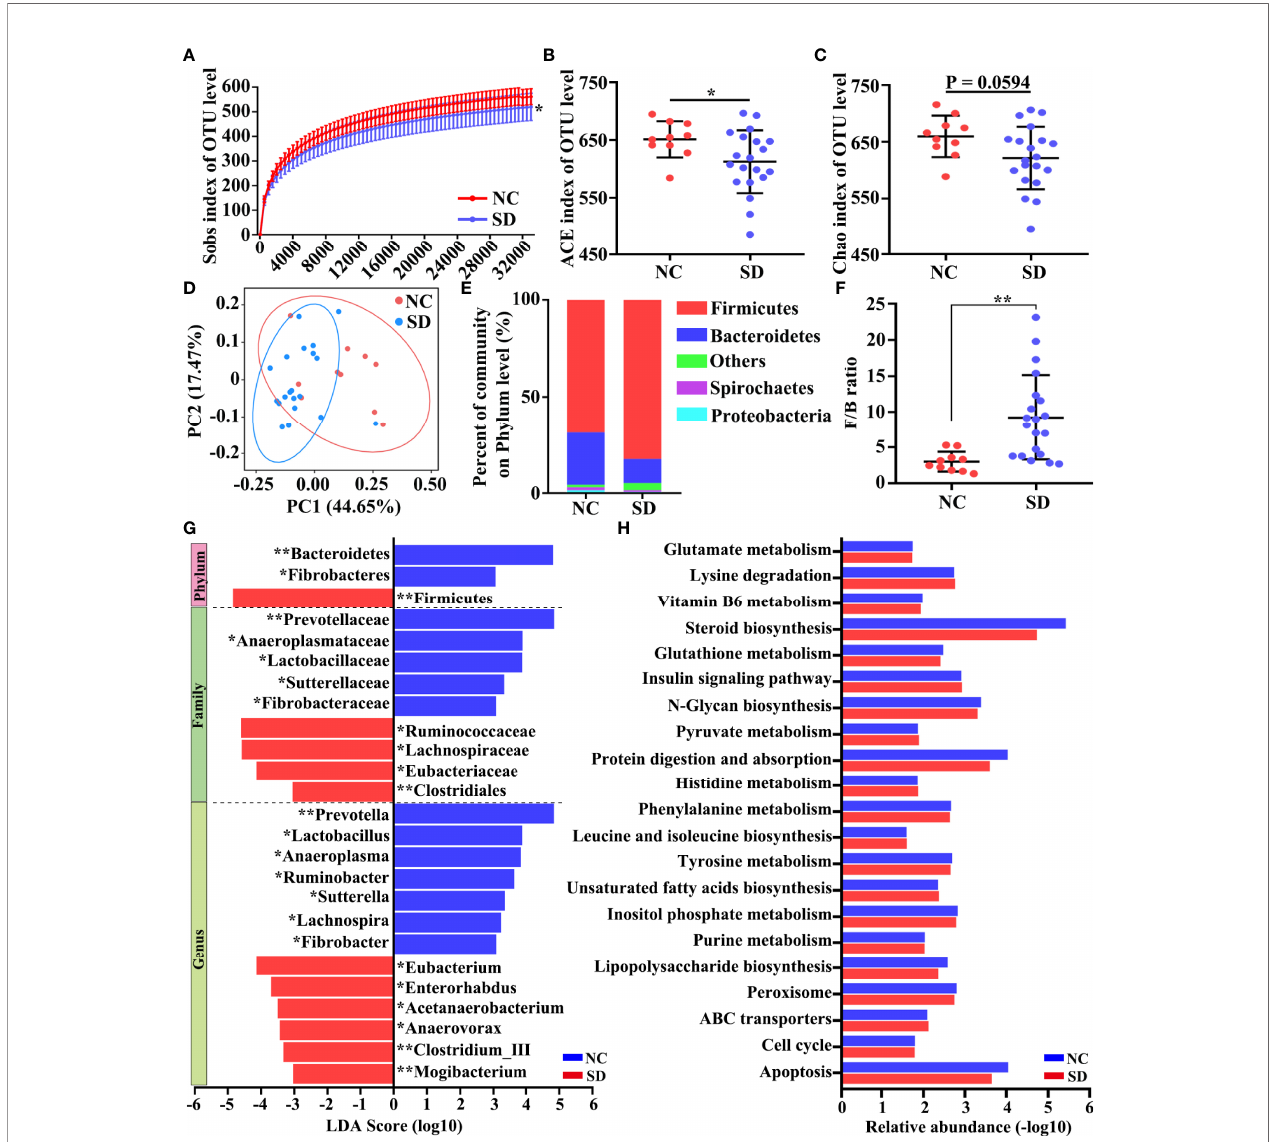
FIGURE 2 | Effects of sleep deprivation (SD) on intestinal microbial community structure in rhesus monkeys (RMs). (A) Rarefaction curves for the gene number in the control ( n = 10) and SD ( n = 20) groups. The curve in each group is nearly smooth with a suf fi cient amount of sequencing data and a few new undetected genes. (B, C) ACE and Chao indices were used to estimate the a -diversity of the gut microbiota community. (D) Principal coordinate analysis showed that there is a distinct clustering of microbial community composition between SD and the control group. (E) The relative abundance of gut microbiota at the phylum level was clustered into different groups. This analysis included only phyla with relative abundances greater than 0.5%. All OTUs with low abundances were grouped as “ others ” . (F) The ratio of Firmicutes to Bacteroidetes in the SD RMs and controls. (G) The differential microbiota community between these two groups was identi fi ed by LEfSe methods. The enriched taxa of SD RMs were indicated with a negative LDA score (red), and the enriched taxa of controls were indicated with a positive LDA score (blue). Only taxa meeting a signi fi cant LDA threshold value of >3 are shown. (H) The differential KEGG pathways based on differential bacteria were shown. Differences were denoted as follows: * p < 0.05; ** p < 0.01. NC, normal control